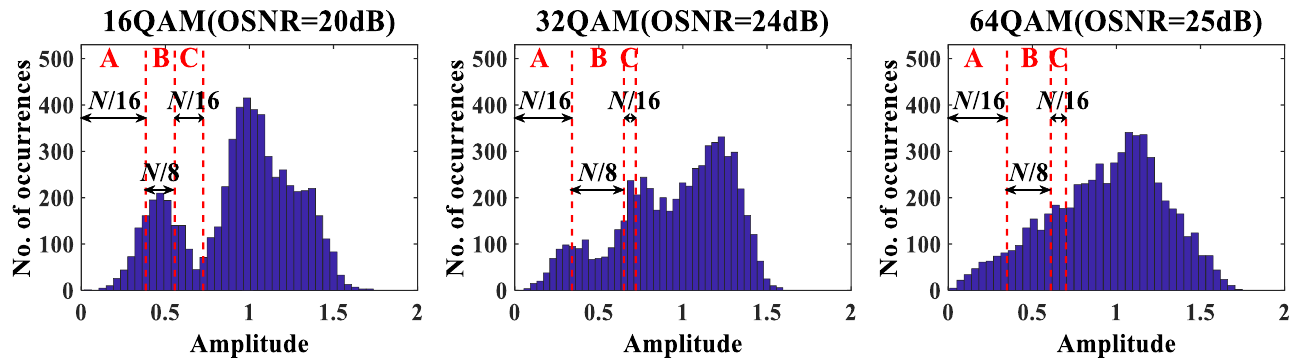
Figure 5. The third partition for the amplitude histograms of 16QAM, 32QAM and 64QAM. The first N /4 symbols are divided into three parts. The numbers of the symbols in part A, B and C are N /16, N /8 and N /16, respectively.